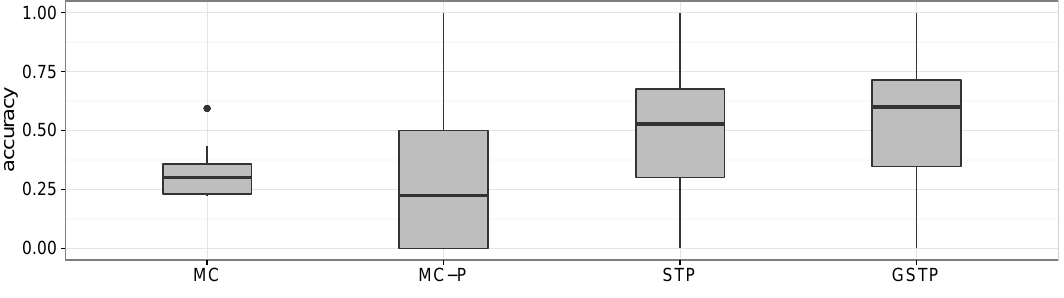
Figure 8. Boxplots for the accuracy results of the methods